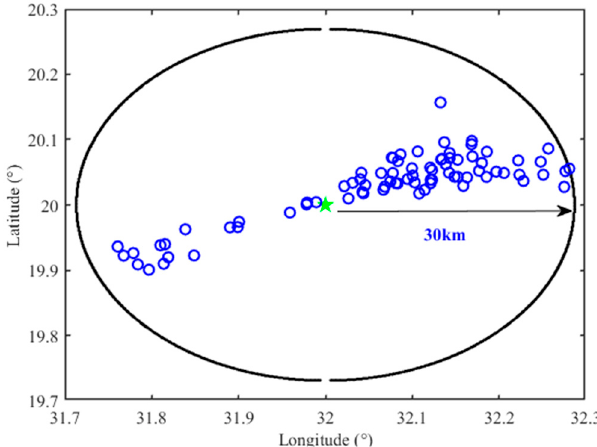
Figure 29. Monte Carlo experiment drop point distribution.